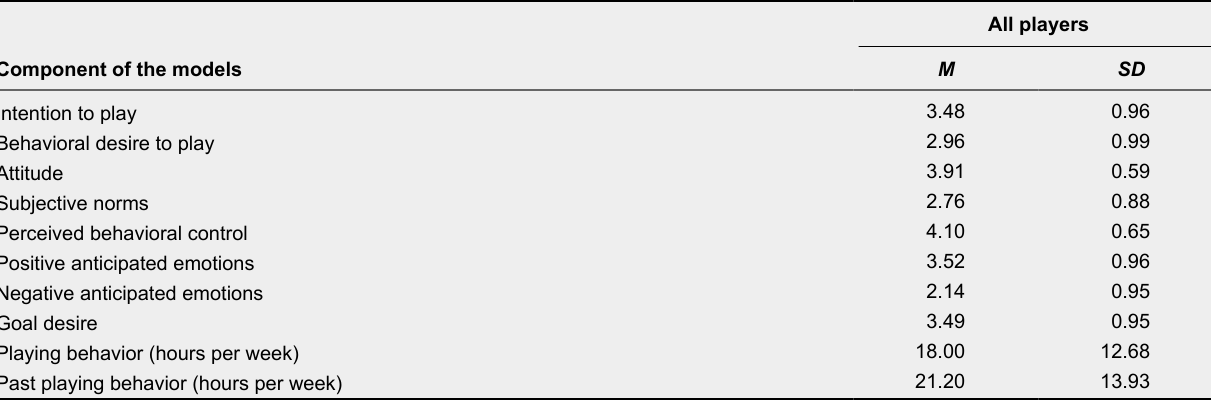
Means and Standard Deviations of the Components of the MGB and the EMGB (N =